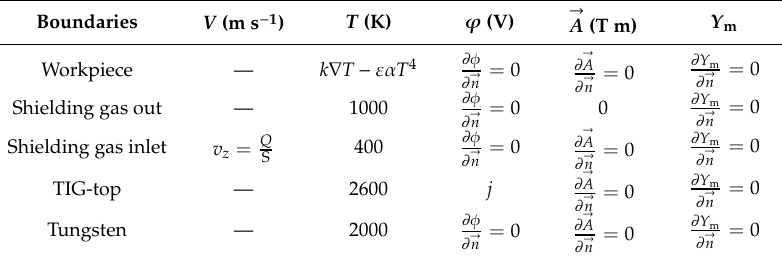
Figure 8. Three-dimensional computation domain. Table 1. Boundary conditions.